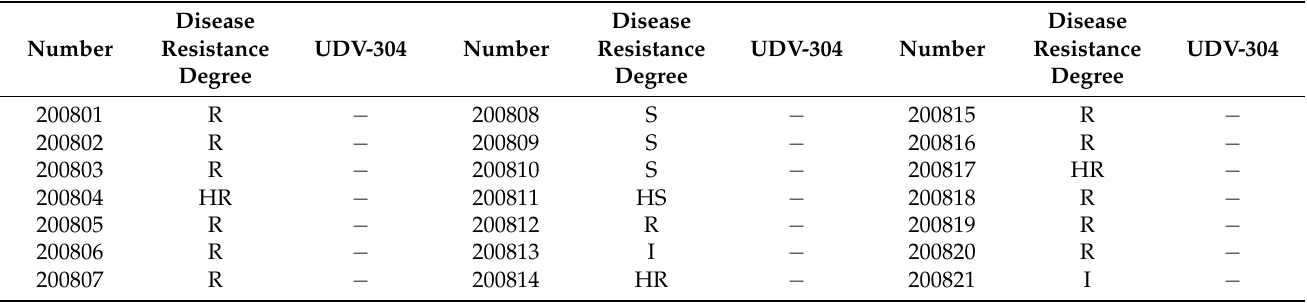
Table 8. Amplification results of UDV-304 marker in combination